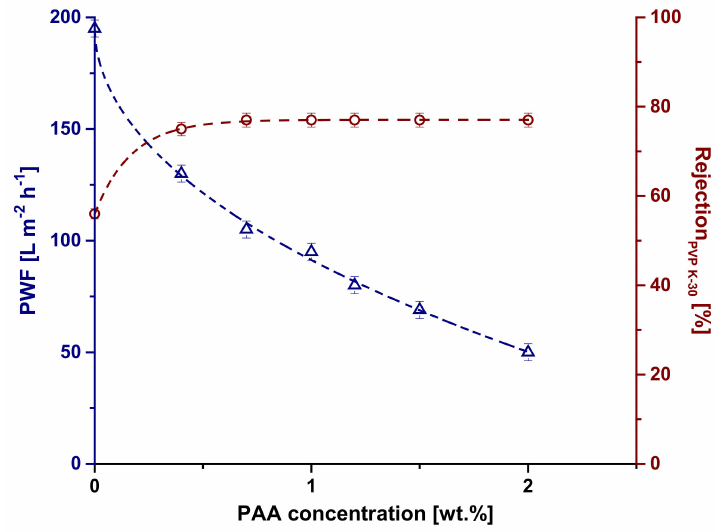
Figure 9. Dependence of PWF and PVP K-30 rejection coefficient (Rejection PVP K-30 ) on PAA concen- tration in the coagulation bath.